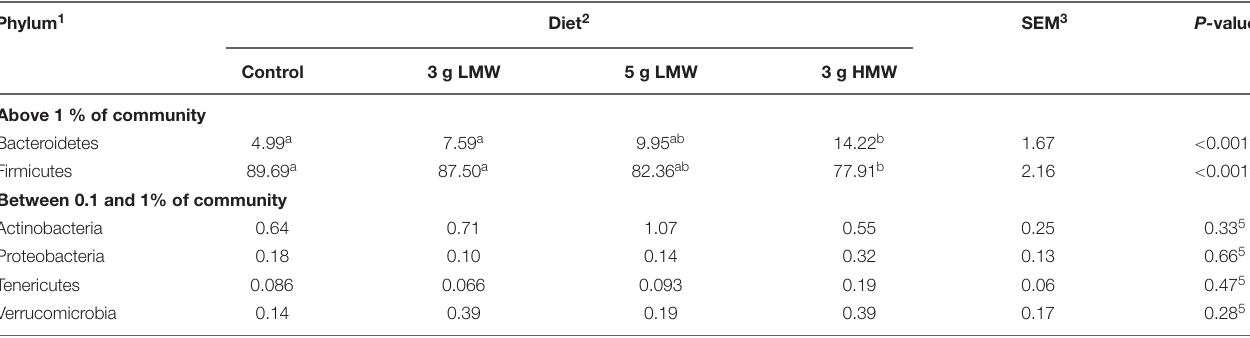
TABLE 2 | Relative abundances of bacterial phyla in feces after β -glucan intervention. Phylum